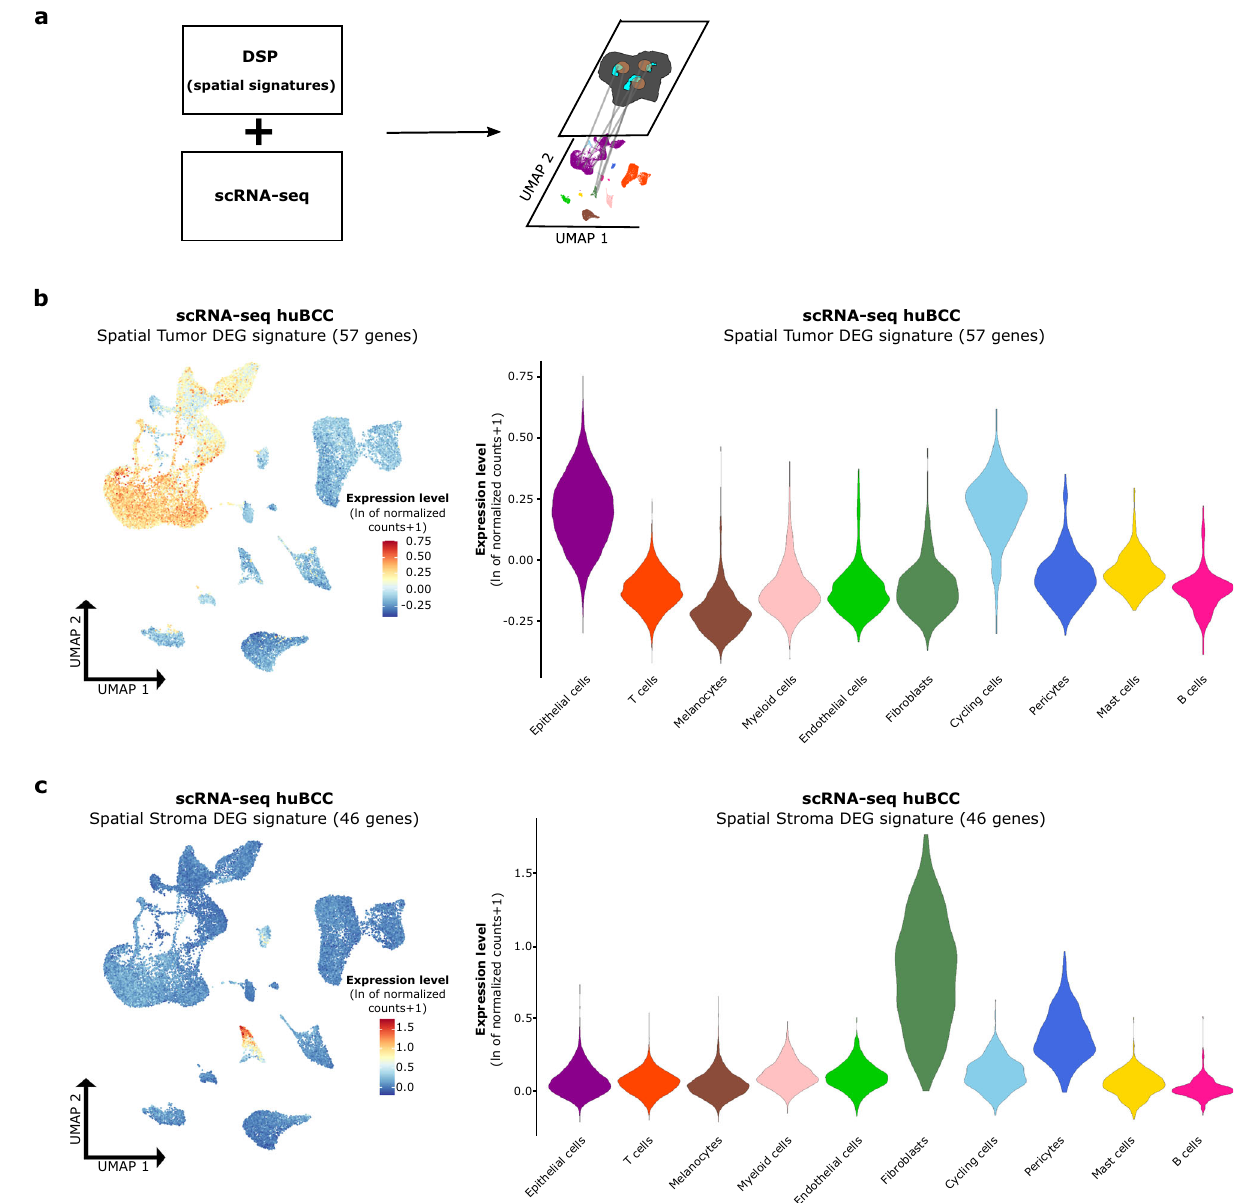
Fig. 3 | Spatial signatures map cell subtypes composing the tumor – stroma interface in in fi ltrative BCCs. a Overview of the analysis pipeline for the applica- tionofspatialsignaturestoscRNA-seqdata.Inbrief,spatialTumorandStromaDEG signatures established with DSP were applied to the scRNA-seq dataset to enable the localization of cells with physical proximity on the UMAP plot. b Average expression level of the spatial Tumor DEG signature in single cells of fi ve huBCC samples,representedasacolorscaleoverlaidontheUMAP(leftpanel)andasviolin